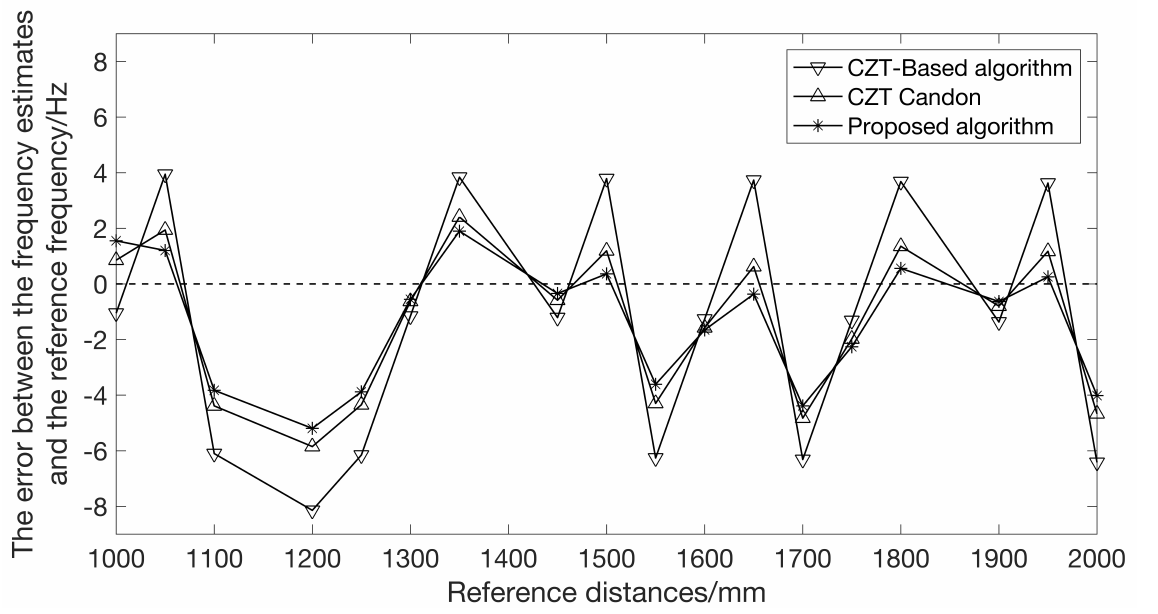
Figure 6. The error between the frequency estimates and the reference frequency under differ- ent